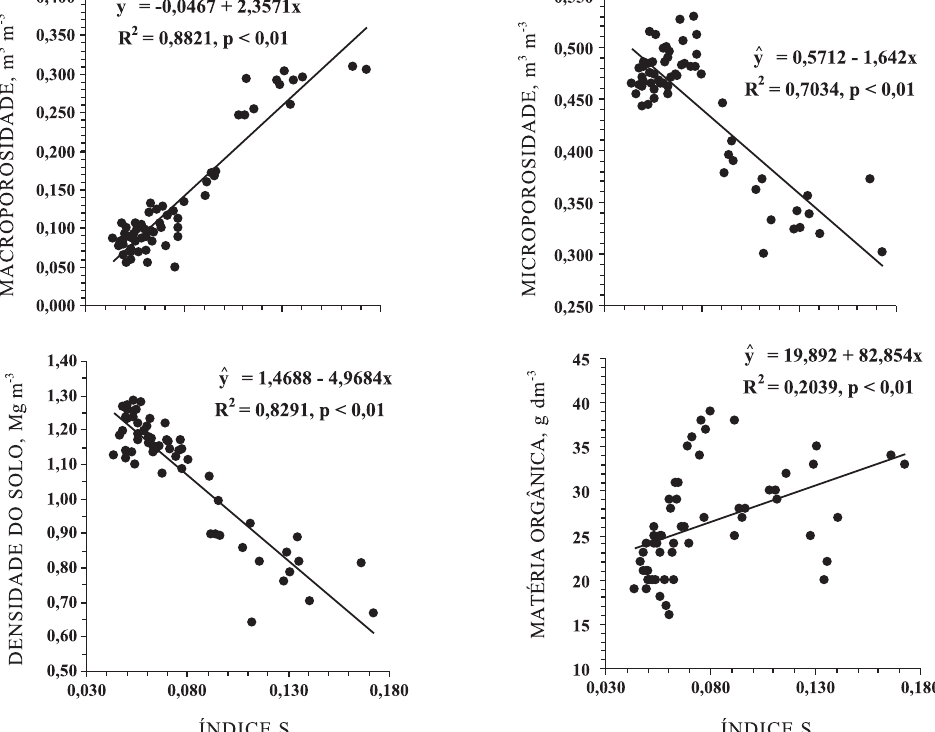
Figura 3. Regressão entre algumas propriedades físicas e matéria orgânica do Latossolo Vermelho acriférrico, em função do índice S (n =